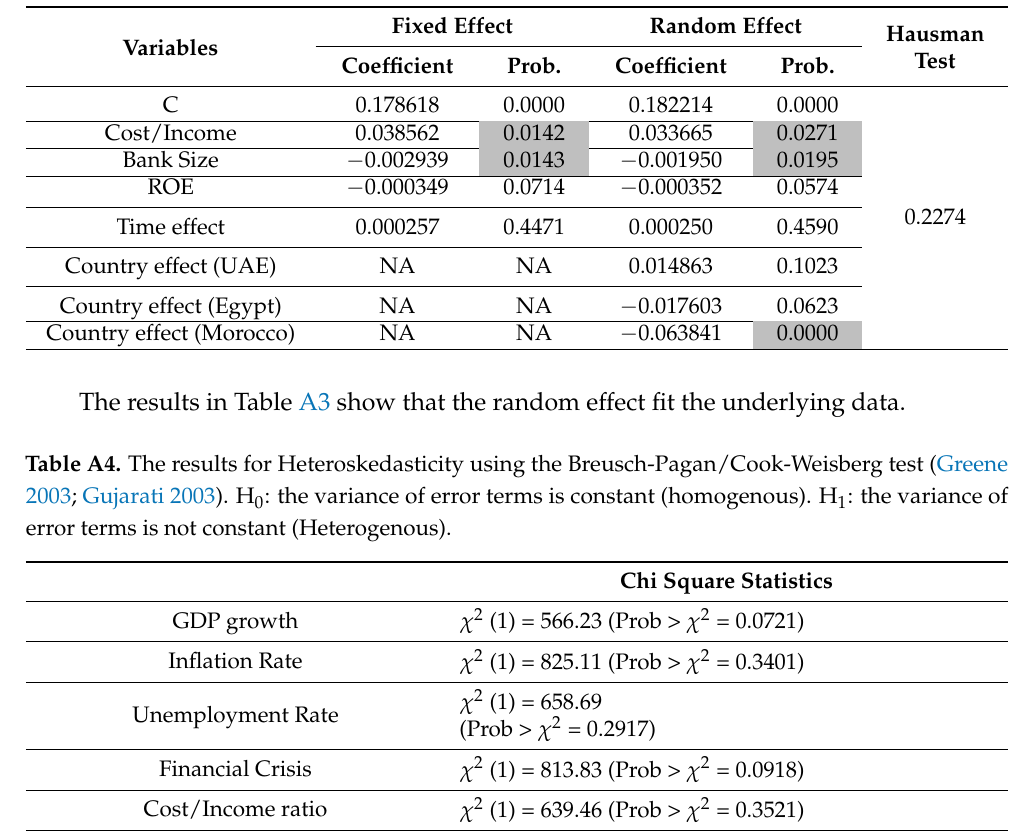
Table A3. The results of the Hausman Test for Bank-specific Variables. The Hausman Specification test was carried out. The null and alternative hypotheses were as follows. Ho: Random-effects model is appropriate; H1: Fixed-effects model is appropriate.